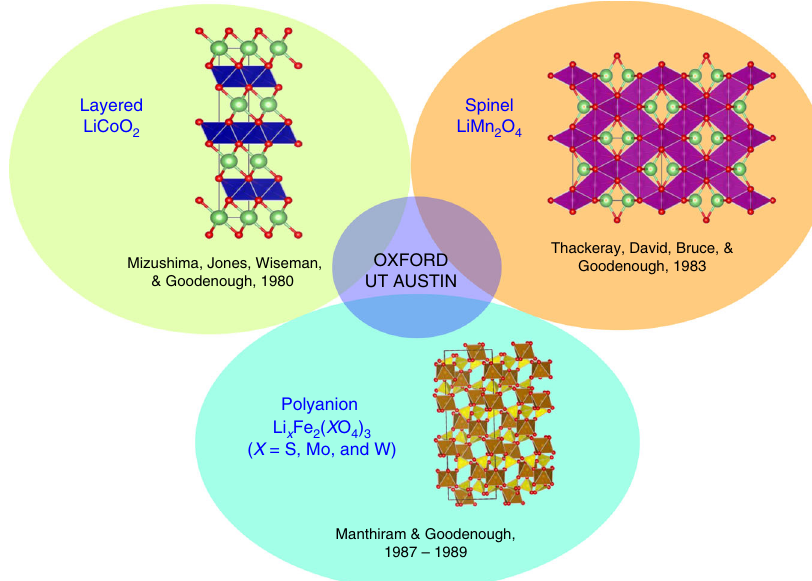
Fig. 2 Discovery of three classes of oxide cathodes in the 1980s. Layered LiCoO 2 with octahedral-site lithium ions offered an increase in the cell voltage from <2.5 V in TiS 2 to ~4 V. Spinel LiMn 2 O 4 with tetrahedral-site lithium ions offered an increase in cell voltage from 3 V for octahedral-site lithium ions with Mn 3 + /4 + couple to ~4 V, with an accompanying cost reduction. Polyanion oxide Li x Fe 2 (SO 4 ) 3 offered yet another way to increase the cell voltage through inductive effect from <2.5 V in a simple oxide like Fe 2 O 3 to 3.6 V, with a further reduction in cost and improved thermal stability and safety. Oxford and UT Austin, refer, respectively, to the University of Oxford and the University of Texas at Austin.